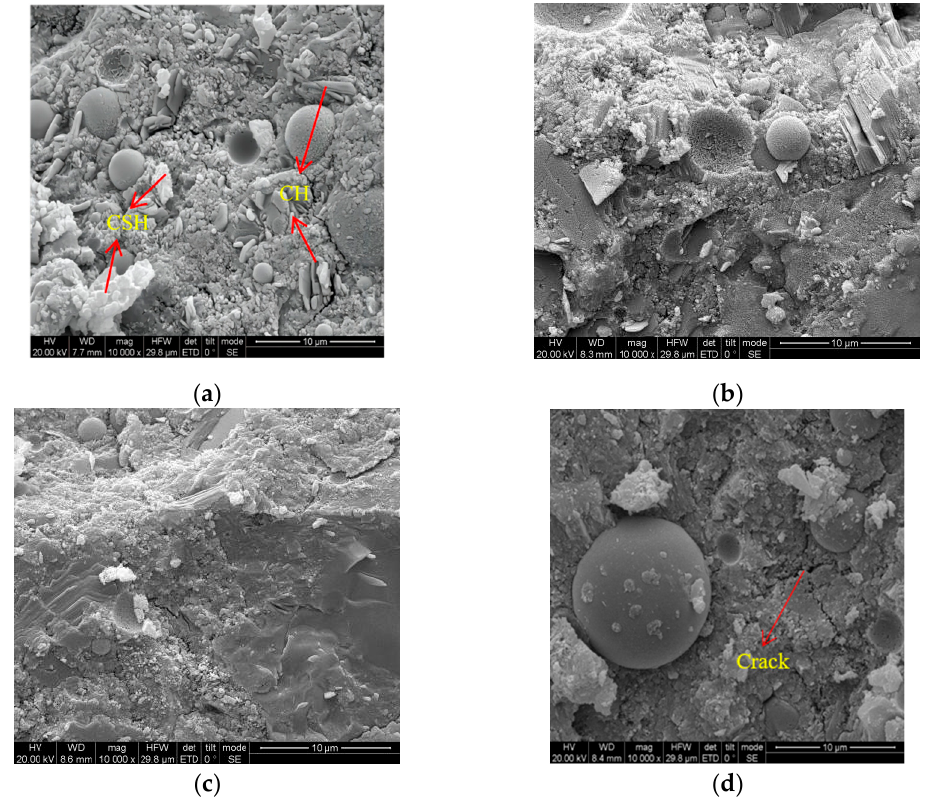
Figure 11. The SEM images of the FDCC under different DS replacing ratios: ( a ) 10%; ( b ) 20%; ( c ) 30%; ( d )